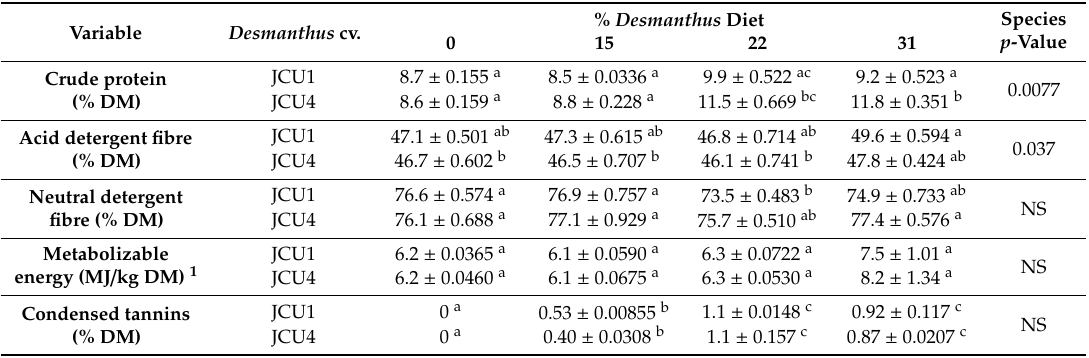
Table 2. Nutritive value (means ± s.e.) of the treatments (JCU1 and JCU4) in the four diet levels (0, 15, 22 and 31% Desmanthus in the